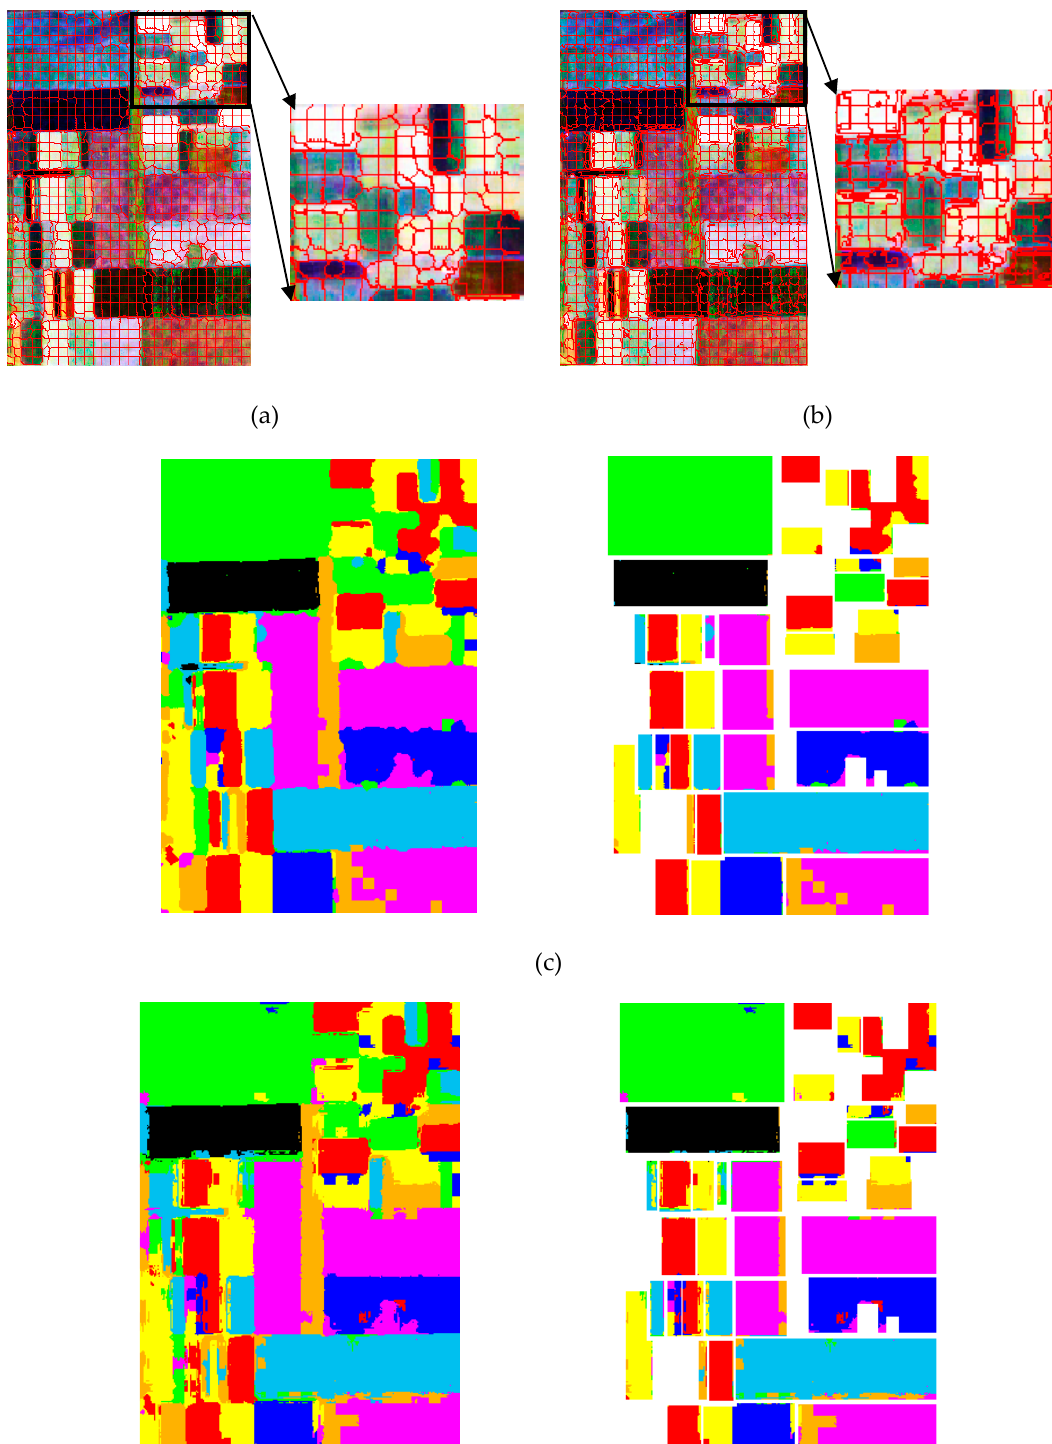
Figure 8. Region-based segmentation and classification results of the Flevoland area. ( a , b ) Segmentation results of the whole image. ( a ) WMRF. ( b ) KMRF. ( c ) Classification result with WMRF. ( d ) Classification result with KMRF.